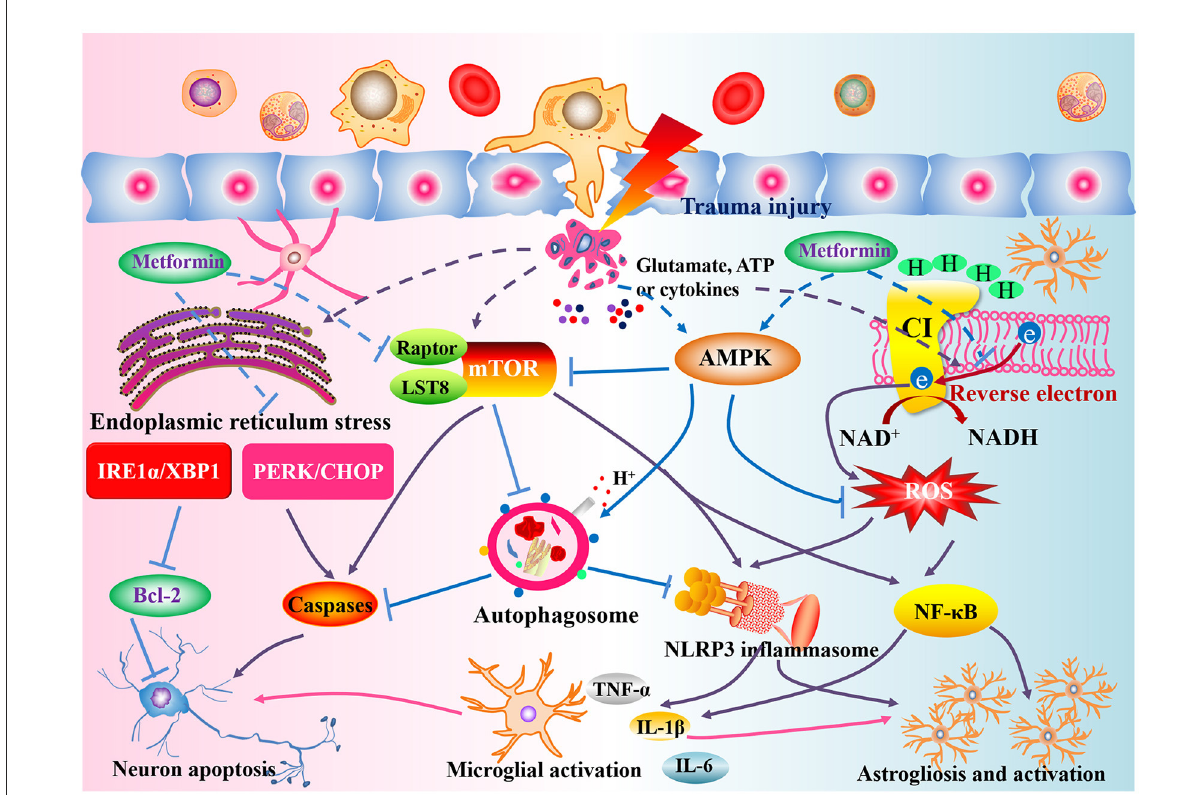
FIGURE8 Potential action mechanisms of metformin against SCI. Following the primary insult, structural damage and a loss of homeostasis trigger the disturbance of energy metabolism, oxidative stress, mitochondrial disorder, endoplasmic reticulum stress, and increased mTORC1 expression. Metformin, the activator of AMPK and well-antioxidant, can modulate the AMPK and reverse electron flow in mitochondria to suppress the ROS generation and activation of NLRP3 inflammasome or NF- κ B signaling, ameliorate endoplasmic reticulum stress to regulate the Bcl-2 and caspase-3, attenuate mTORC1 activation to induce the autophagosome formation, thereby exerting a satisfactory neuroprotective role in SCI